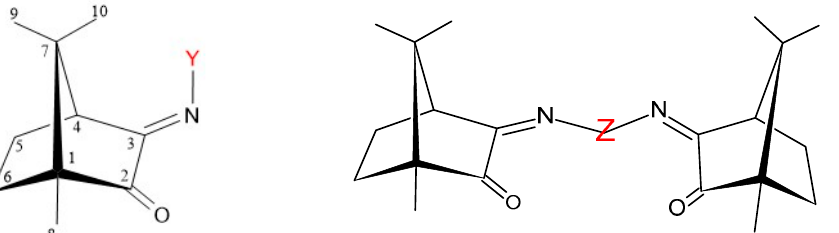
Figure 1. Camphorimine compounds used as ligands: type A ( left ), Y = C 6 H 5 ( 1 A), C 6 H 4 NH 2 ( 2 A); type B ( right ), Z = 4-C 6 H 4 ( 1 B), 3-C 6 H 4 ( 2 B).